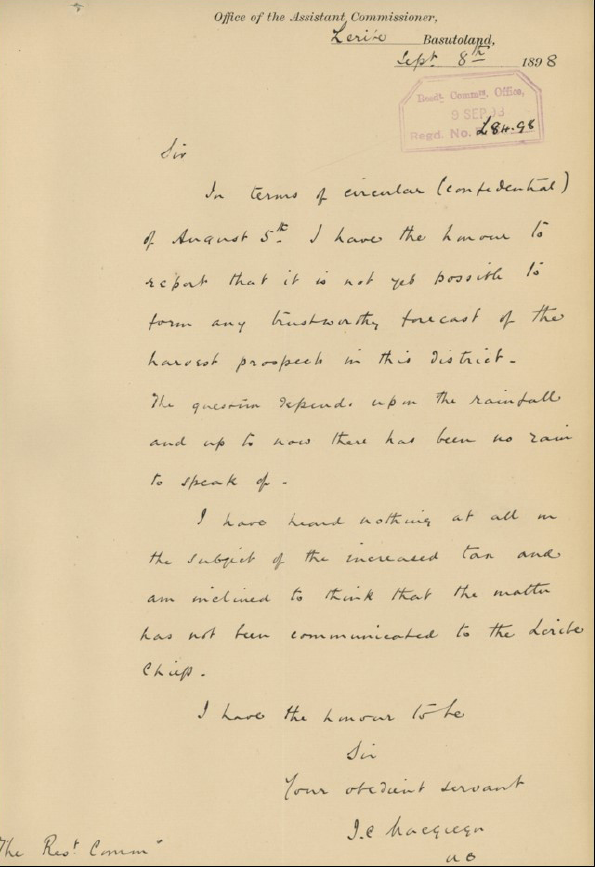
Figure 2. Example letter written by Assistant Commissioner for Qacha’s Nek District, J. L. McGregor (Leribe, Lesotho), dated 8 September 1898 (Source: Lesotho National Archives, Incoming Letters – Qacha’s Nek District S7/1/6/6).